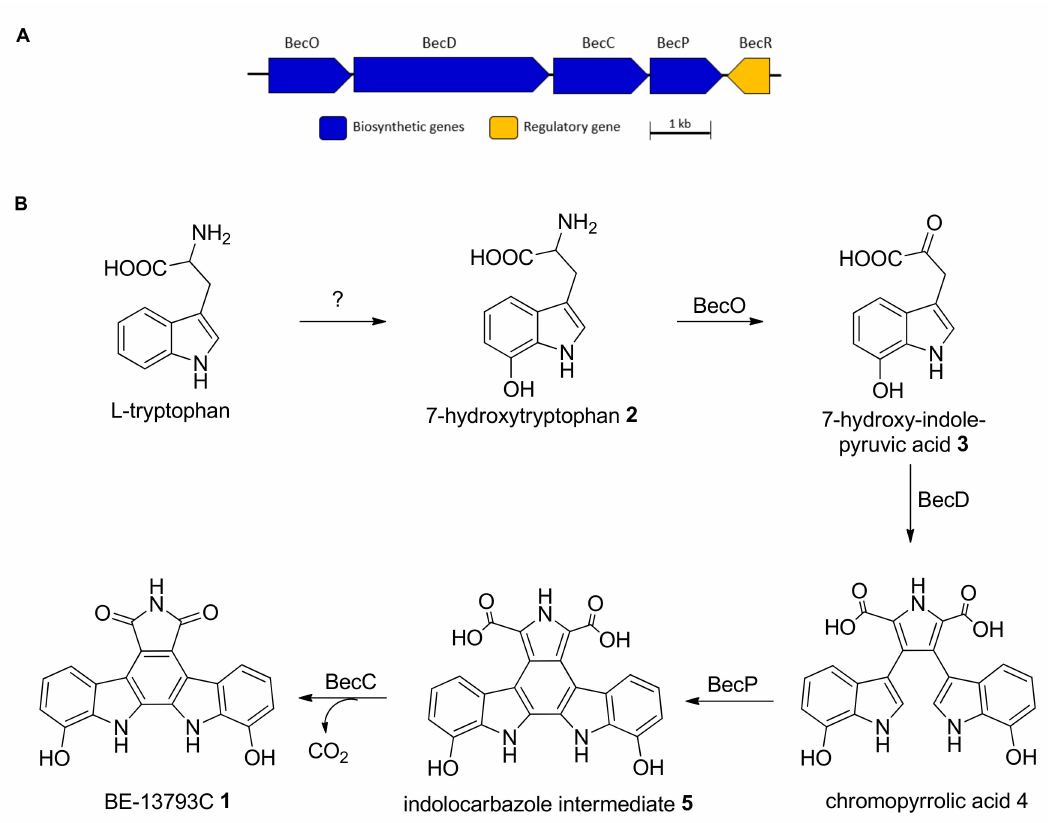
Figure 4. ( A ) Biosynthetic gene cluster of BE-13793C 1 in Streptomyces sp. MA37 and ( B ) Proposed biosynthetic pathway of 1